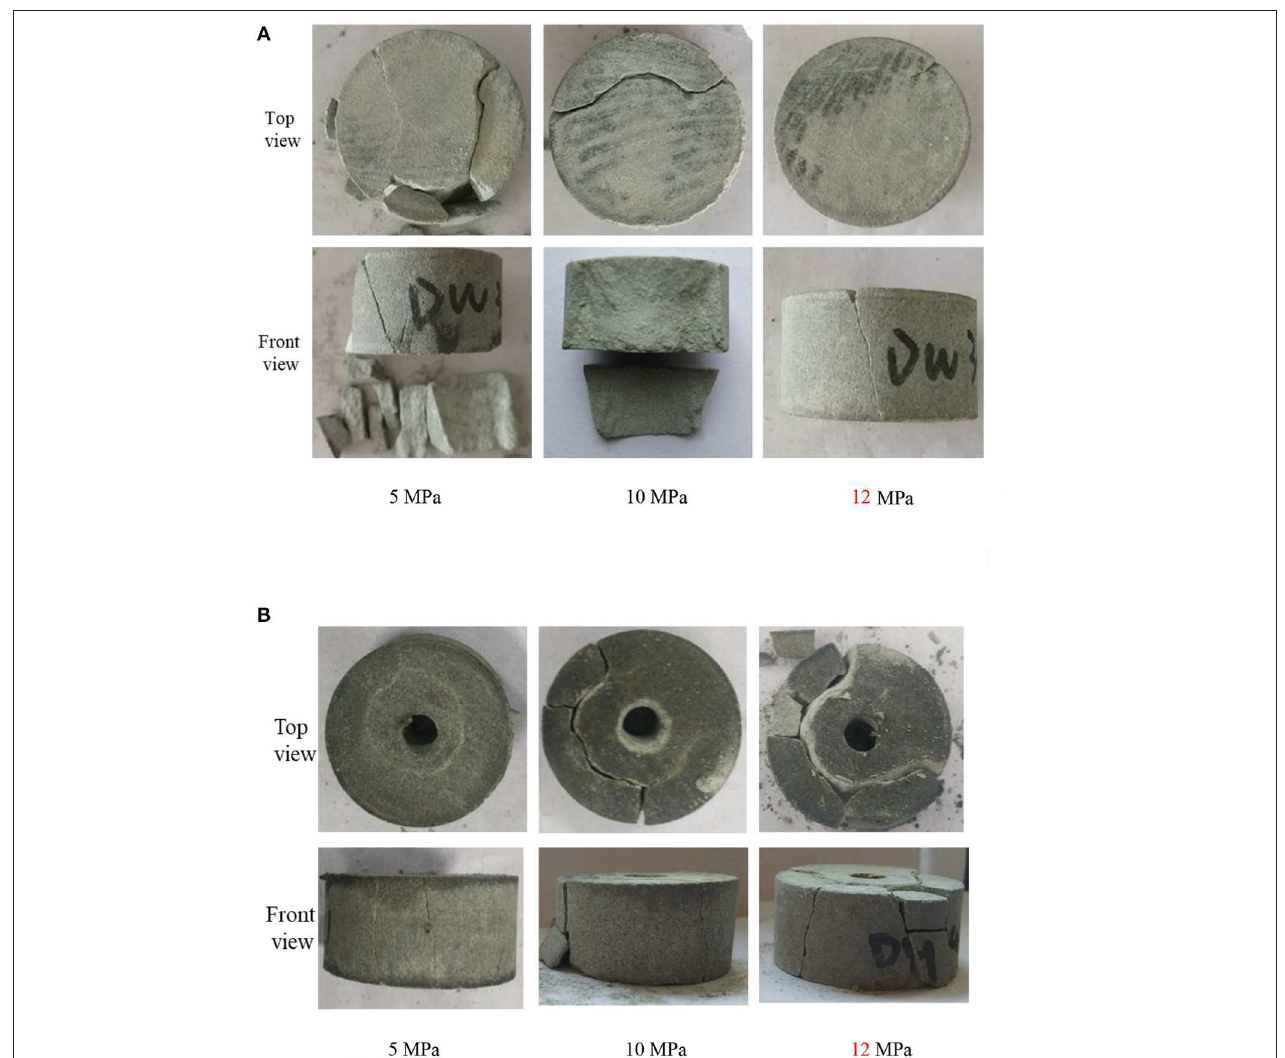
FIGURE 10 | Failure modes of sandstone impact under cyclic loading under difference stress modes: (A) Type A, (B) Type